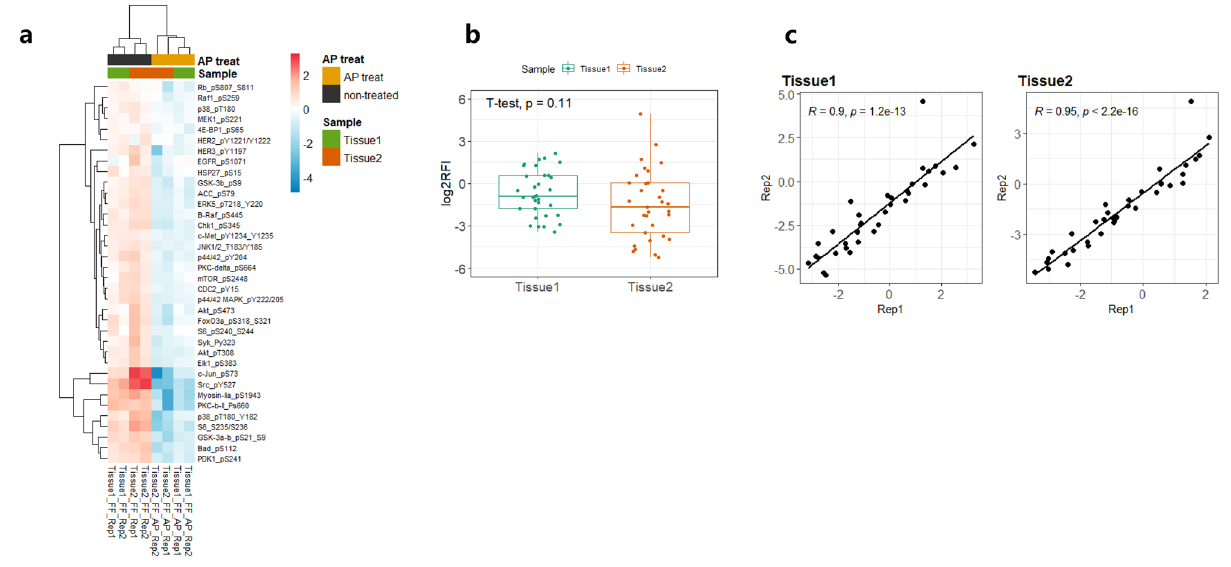
Figure 4. RPPA assessment of AP treatment in FF tissue samples. ( a ) Unsupervised hierarchical clustering of tissue samples treated with (yellow) or without AP (black) based on RPPA profiling of 36 phospho-markers. Rep1 and Rep2 represent two independent tissue sites derived from the same patient and for each site, extraction was performed on two parallel sections separately. ( b ) Overall expression profiling between two tissue sites (Rep1 and Rep2). Data are shown in log2 transformed RFI (relative fluorescence intensity) and unpaired t-test was used to assess the differential expression between two tissue sites. c. Inter-replicate expression correlation presented by RFI from individual tissue sites. Pearson correlation coefficients are